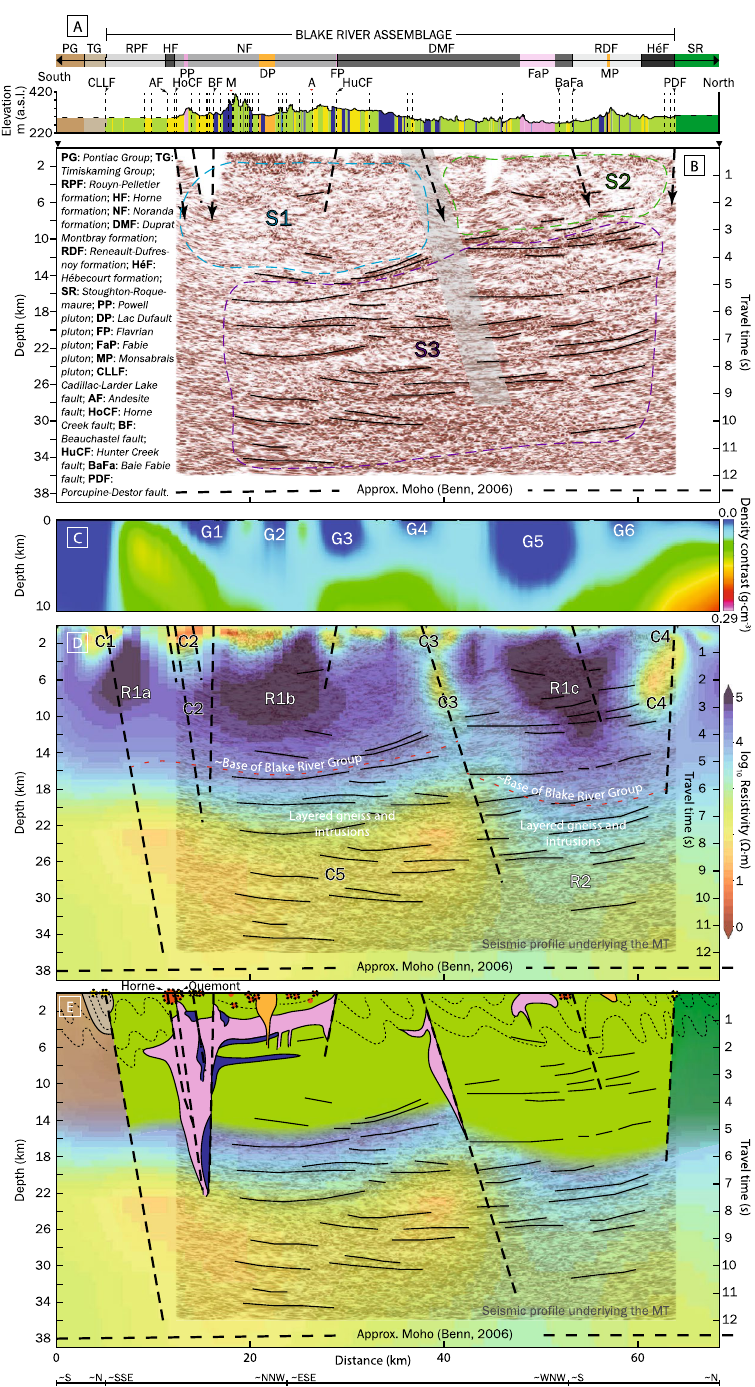
Figure 2. Geological ( A ; see Fig. 1 legend), seismic ( B ), density ( C ), and MT with interpreted solid black subhorizontal reflectors and dashed black subvertical faults ( D ) sections along the Metal Earth transect (Fig. 1). ( E ) Interpreted section showing VMS and orogenic Au deposits as red and yellow circles (on transect), respectively, with black dotted outline (projected). S1-3, G1-6, C1-5, and R1-2 correspond to features of interest discussed in the text. The Figure was compiled in Adobe Illustrator (≥ v. CC2018 22.0.0) with the geological section in panel A ) generated using open data downloaded from Système d’information géominière of